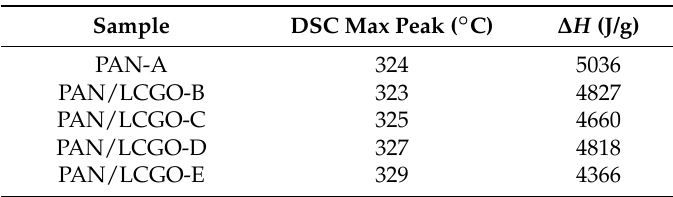
Figure 6. Differential scanning calorimetry (DSC) curves of the PAN and PAN/LCGO nanofibrous twisted yarns. Table 2. The stabilization temperature and heat of fusion ( ∆ H ) of PAN and PAN/LCGO nanofibrous twisted yarns.